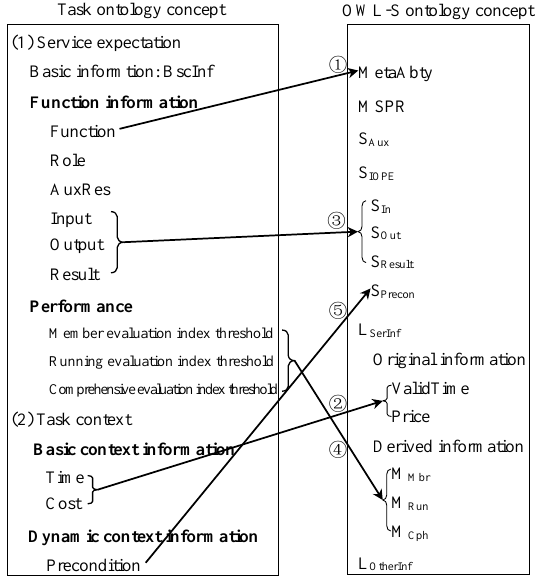
Figure 11. The multistage matching between task and service.